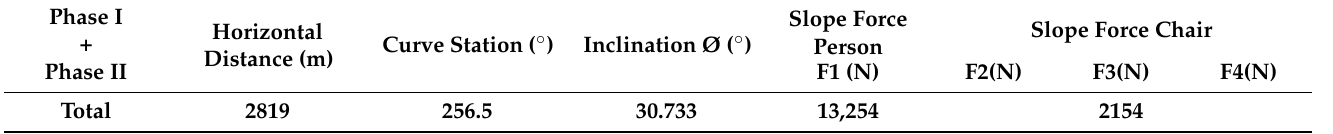
Table 4. Combined Framework of Phase I and Phase II.